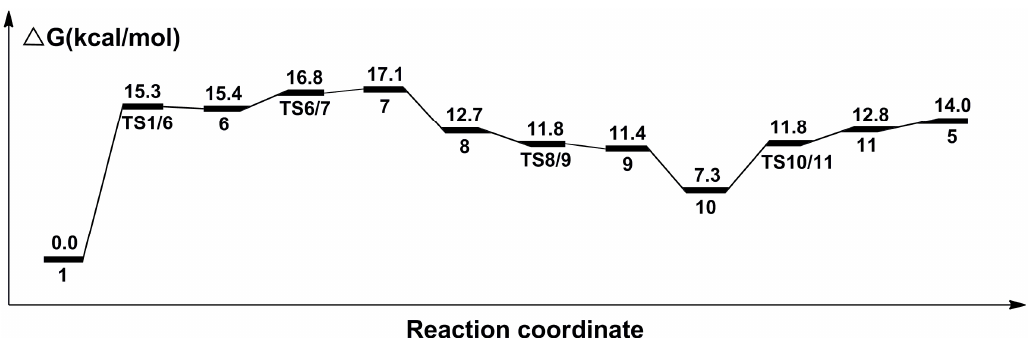
Figure 5. Calculated relative free energies in the catalytic process for the hydrogenation of formic acid to formaldehyde and water.